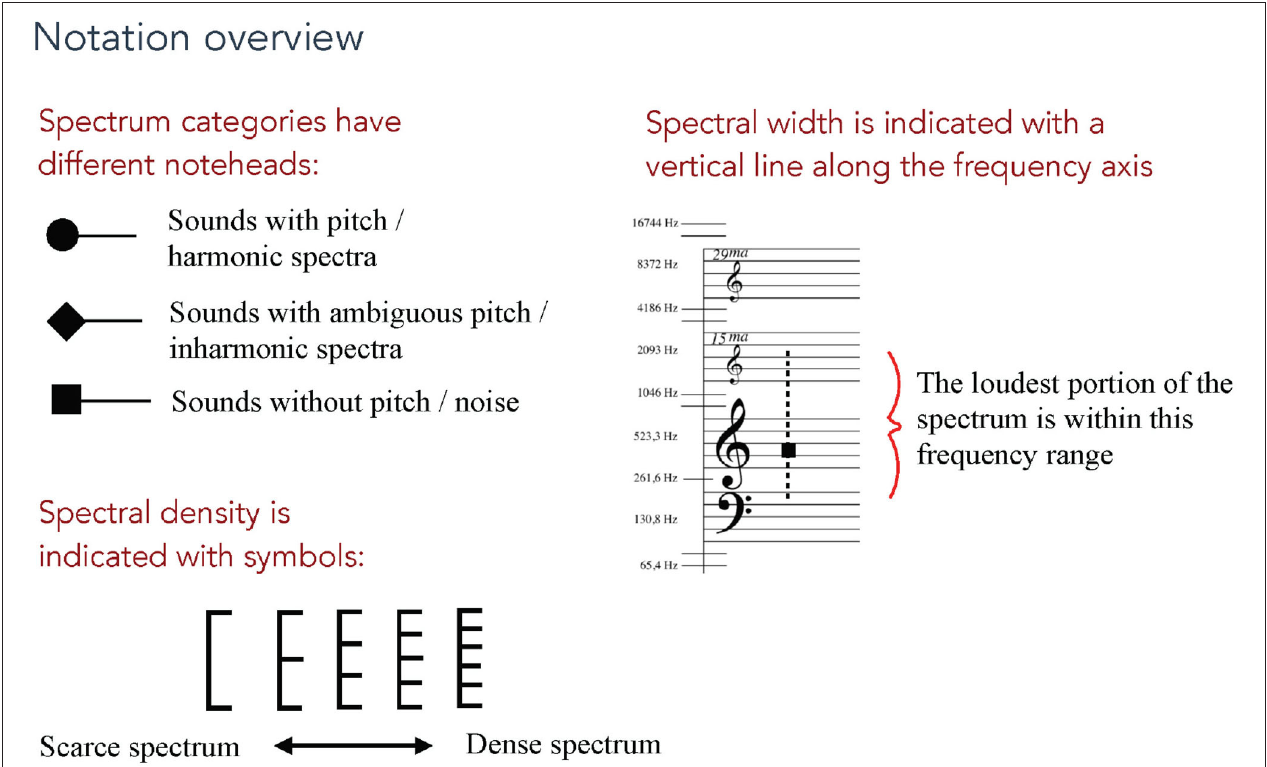
FIGURE 4 | Overview of the notation features in focus in the listening tests. The three parts of this image were presented separately in the beginning of the multiple-choice test. And this image was also available as a PDF download for participants to use as a reference throughout the